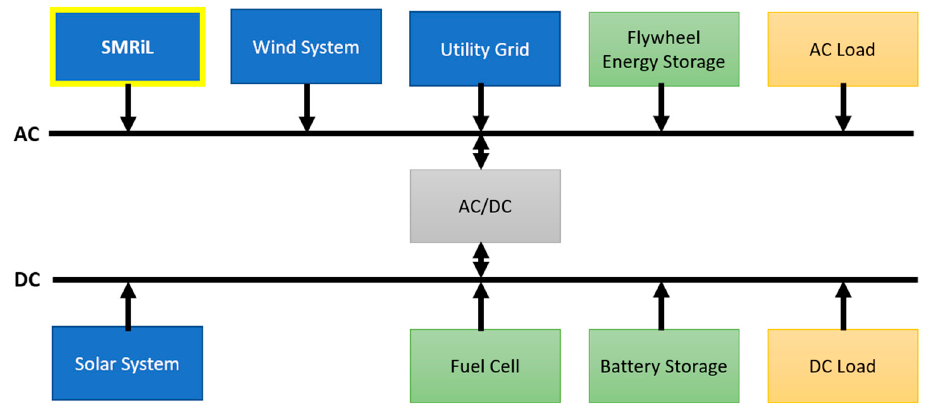
Figure 8. Nuclear-renewable hybrid energy system.